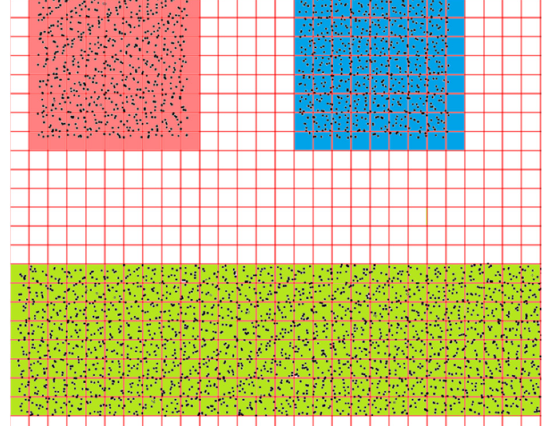
Figure 2. Examples of the grid-based DBSCAN algorithm.